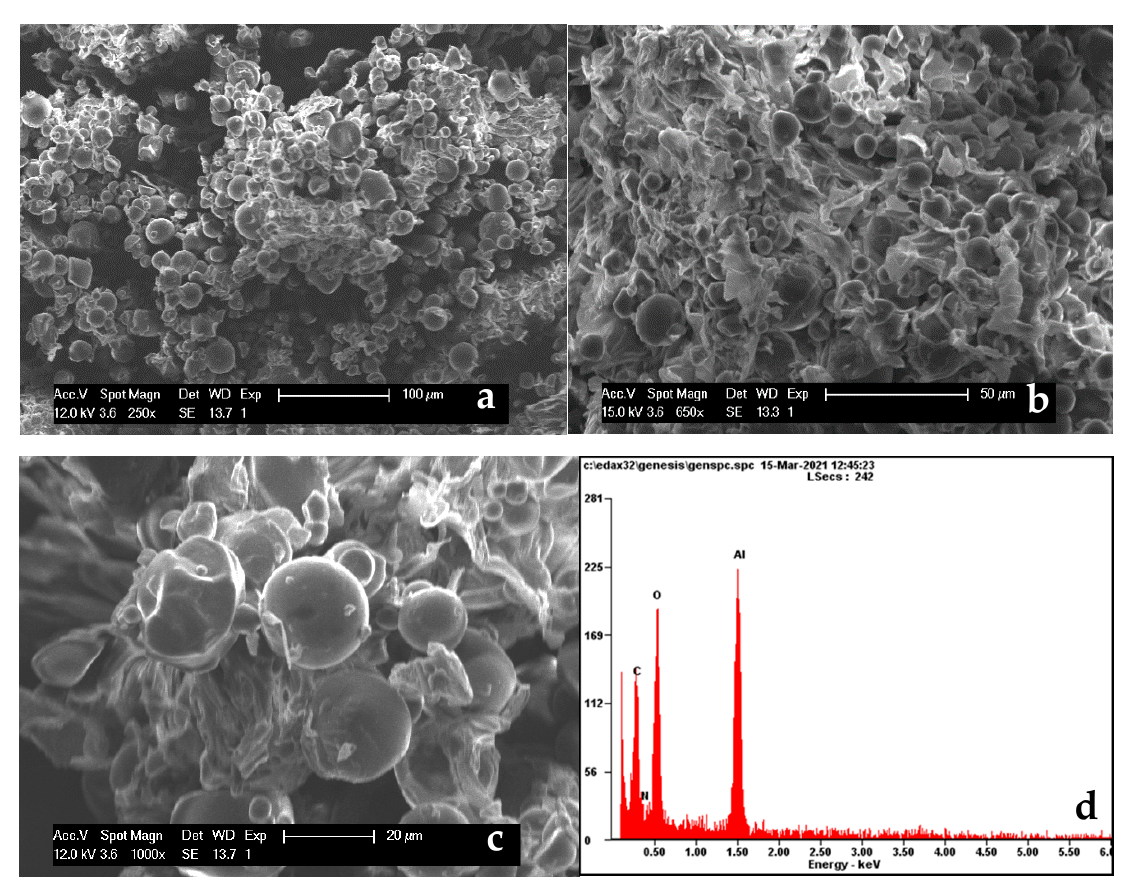
Figure 4. SEM pictures ( a – c ) of the sweet potato residue at ( a ) magnification 250 × , ( b ) magnification 650 × , ( c ) magnification 1000 × and EDX spectrum ( d ) of the sweet potato residue metallized by aluminium.